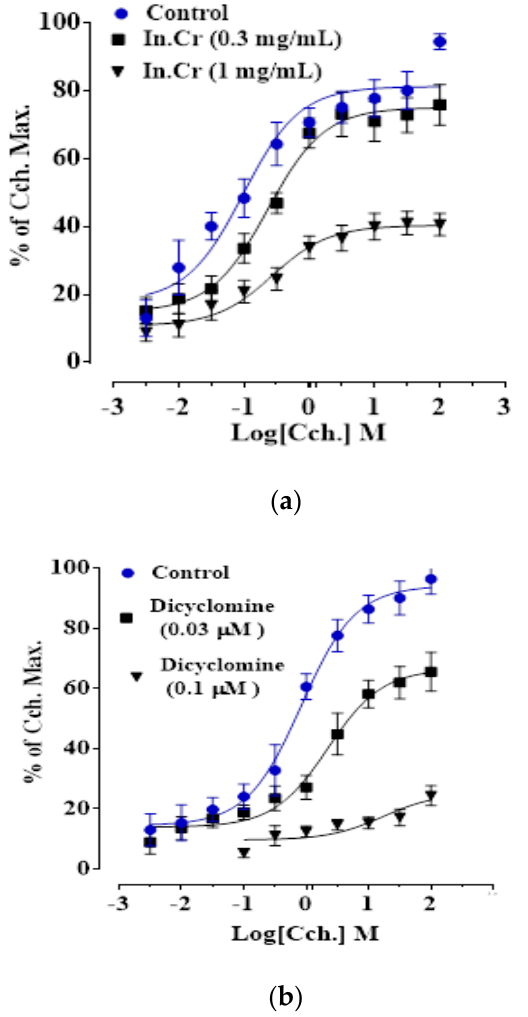
Figure 3. Dose-response arches of carbachol in the nonexistence and existence of the increasing extent of: ( a ) In.Cr and ( b ) dicyclomine. ( n = 5).